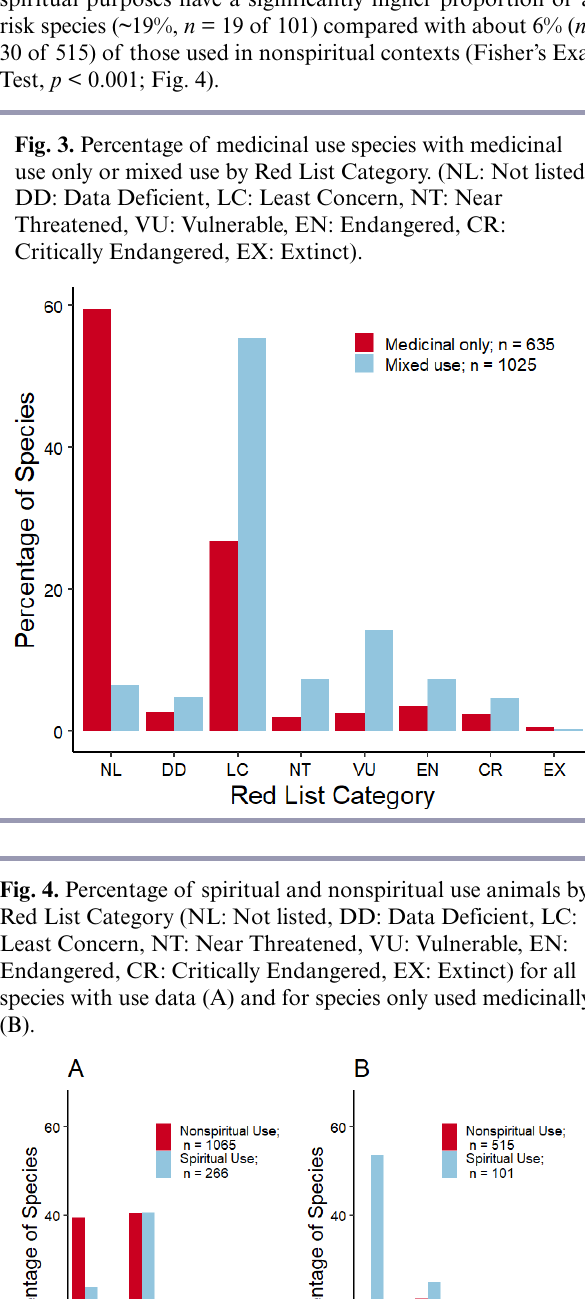
Fig. 2. The number of animal species used for medicine (A), the proportion of animal species used for medicinal purposes (B), and the proportion of those that are at risk (“Vulnerable”, “Endangered”, or “Critically Endangered”) (C).